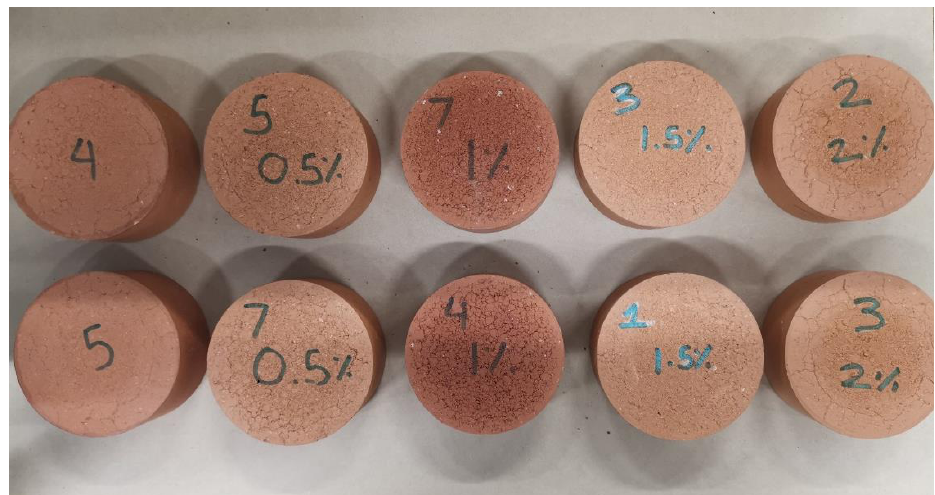
Figure 6. Some of the samples prepared in this study.